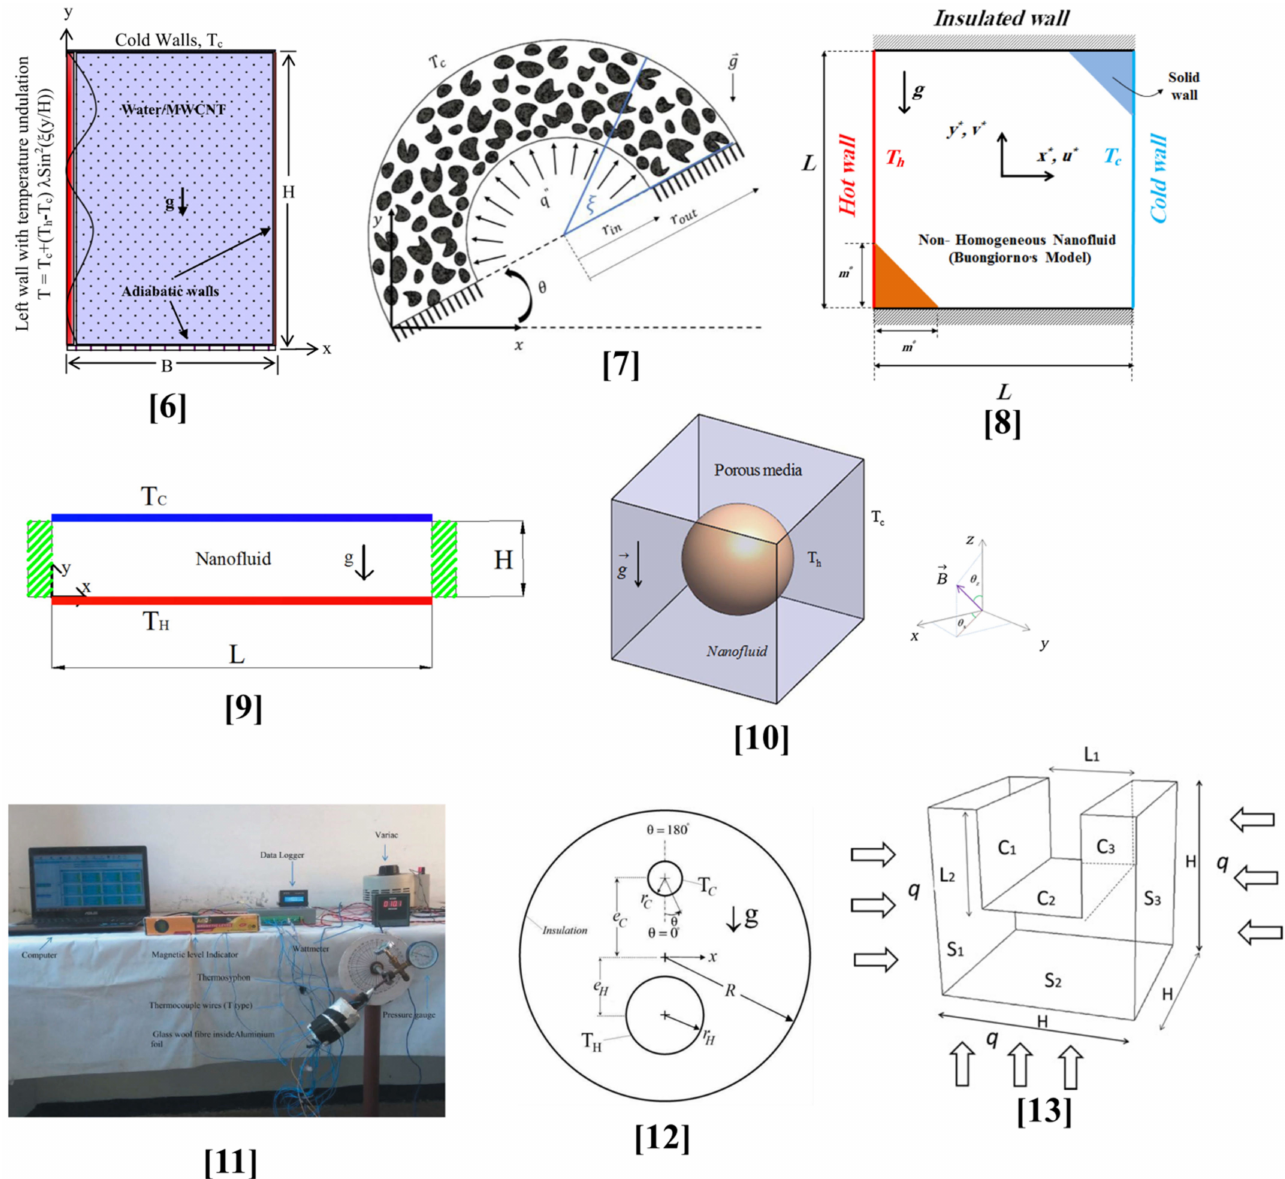
Figure 1. Design description of the works presented in the literature